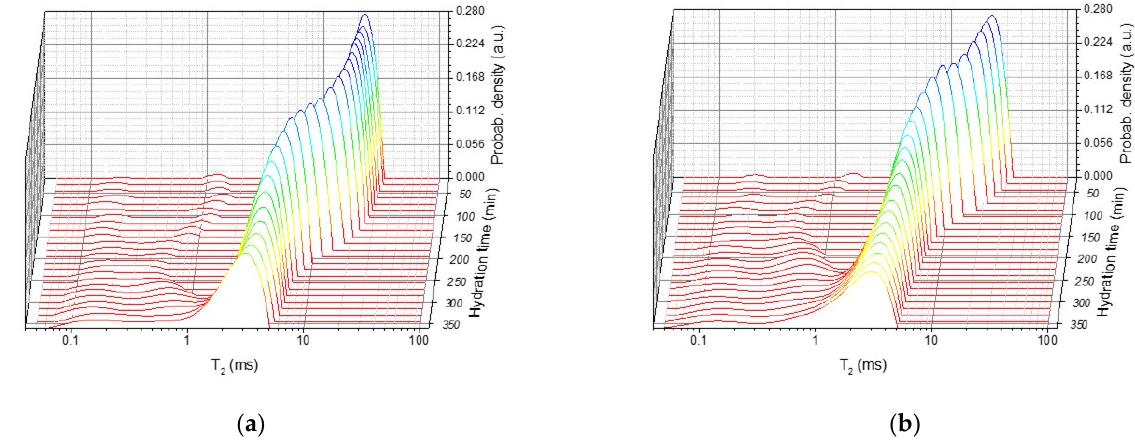
Figure 2. Relaxation time distributions for the two samples, at different hydration times, as indicated in the legend: ( a ) Cement paste sample prepared at a water-to-cement ratio of 0.4; ( b ) Cement paste prepared at 0.4 water-to-cement ratio which additionally contains 3% accelerator (Ca(NO 3 ) 2 ), by cement mass.